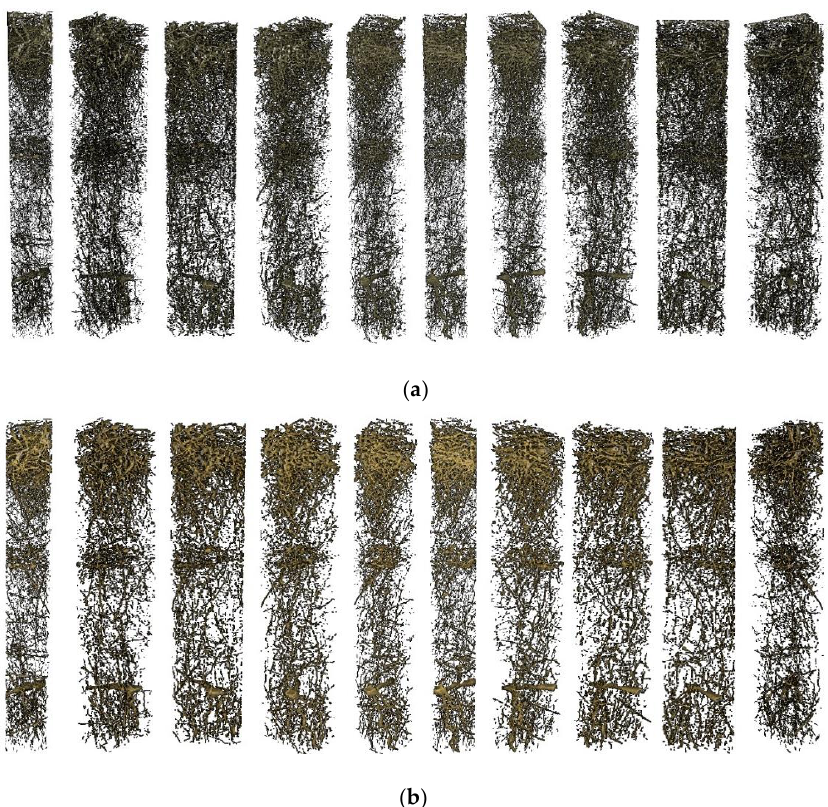
Figure 5. Image series of 3D model for RWSN rotating clockwise. ( a ) Unfiltered and with ice on top, ( b ) with size filter and ice removed. The size of the monolith is 6.0 cm × 10.1 cm × 44.6 cm.